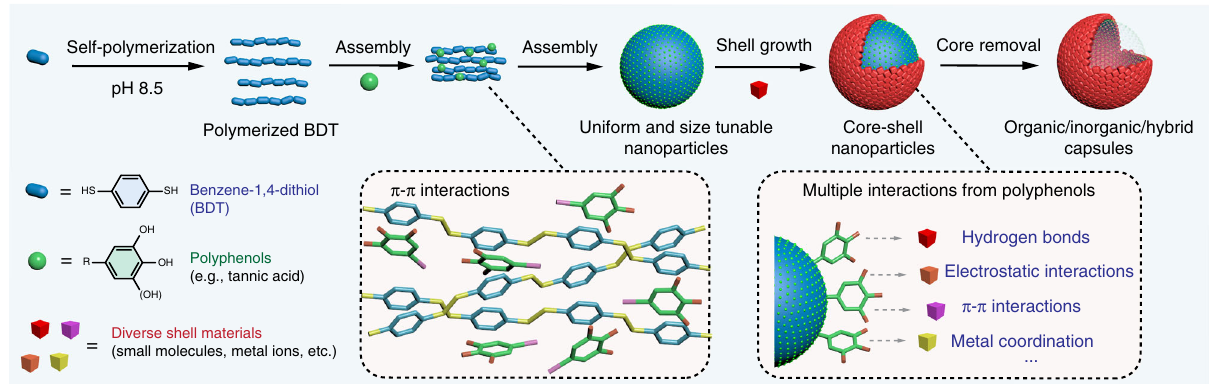
Fig. 1 Synthetic strategy for particle engineering using supramolecular networks. Schematic of the synthesis of supramolecular particles through the controlled self-assembly of pBDT and polyphenols via π – π interactions. The polyphenol-stabilized particles allow for the subsequent growth of diverse shell materials on the particles. Disassembly of the supramolecular complexes in the core results in hollow